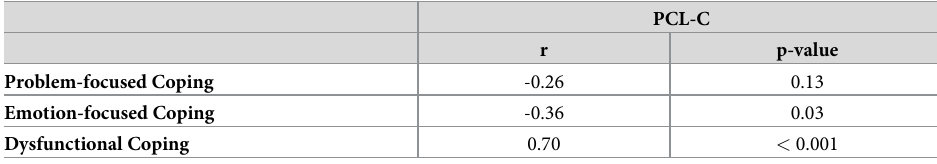
Dysfunctional Coping 0.70 < 0.001 Note. PCL-C = Posttraumatic Stress Disorder–Civilian